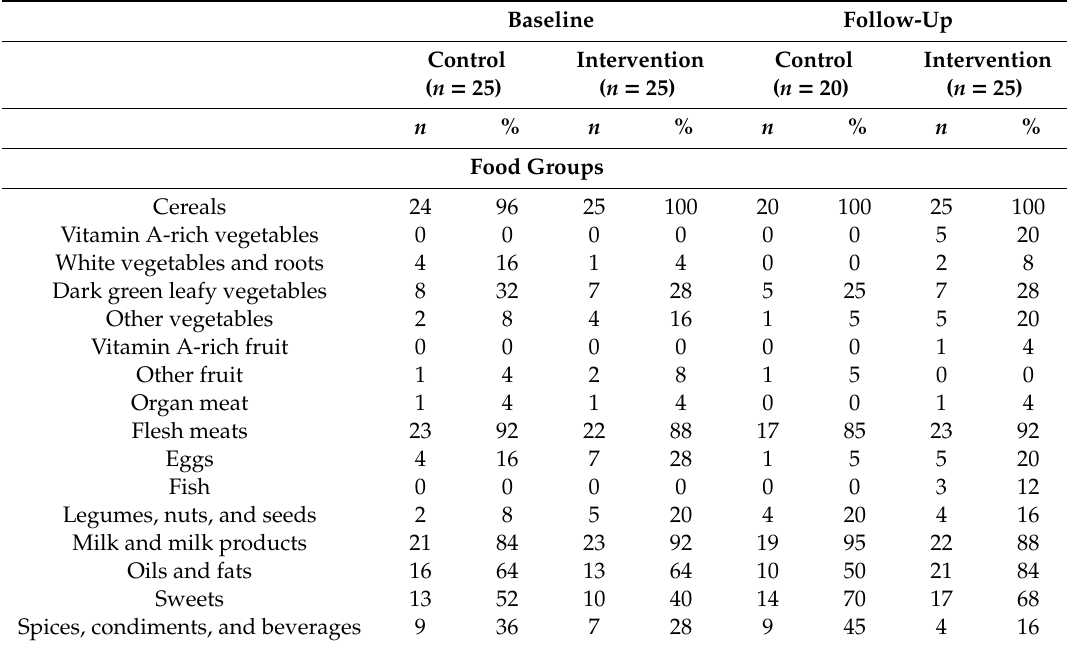
Table 5. Household Dietary Diversity of control and intervention groups at baseline and follow-up.